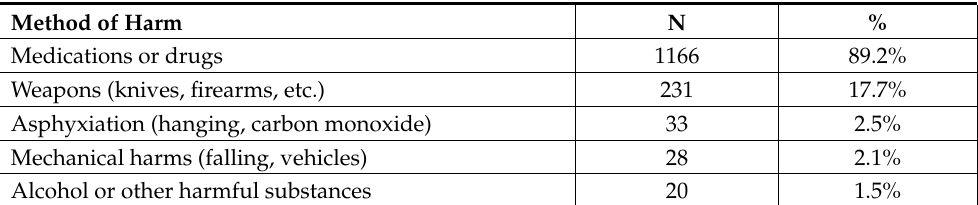
Table 3. Categories of methods of harm reported in hospitalizations for suicide attempts in patients with Alzheimer’s disease and related dementias, 2016–2018.